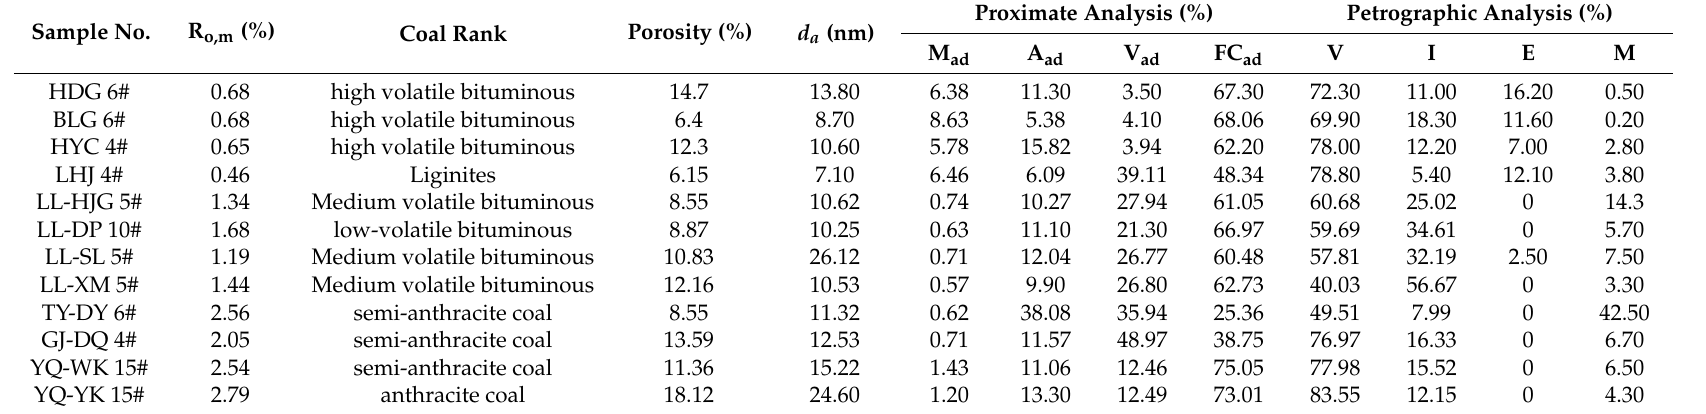
Table 1. Results of the MIP, petrographic and proximate analysis of the coal samples.